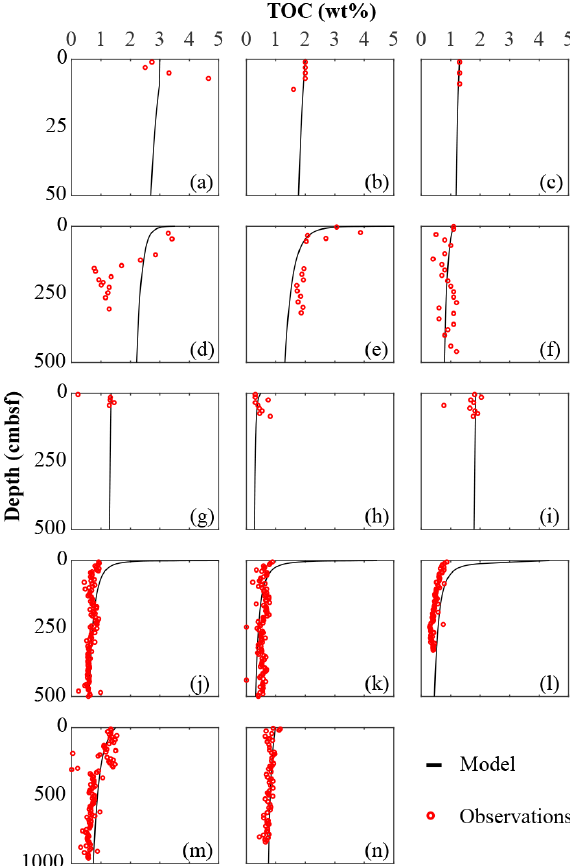
Figure 2. Total organic carbon data–model best fit: (a) Severn estuary; (b) Rhone pro-delta; (c) Rhone shelf; (d) Aarhus Bay; (e) Arkona Basin; (f) Helgoland mud area, North Sea; (g) Skagerrak – S10; (h) Skagerrak – S11; (i) Skagerrak – S13; (j) Arabian Sea – OMZ core; (k) Arabian Sea – OMZ transition; (l) Arabian Sea – below OMZ; (m) Bering Sea; (n) Argentine